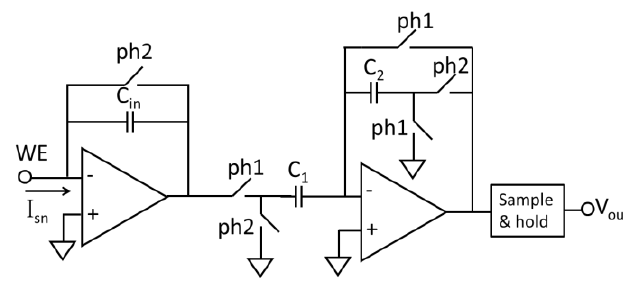
Figure 9. The structure of CDS circuit (adapted from [47]).